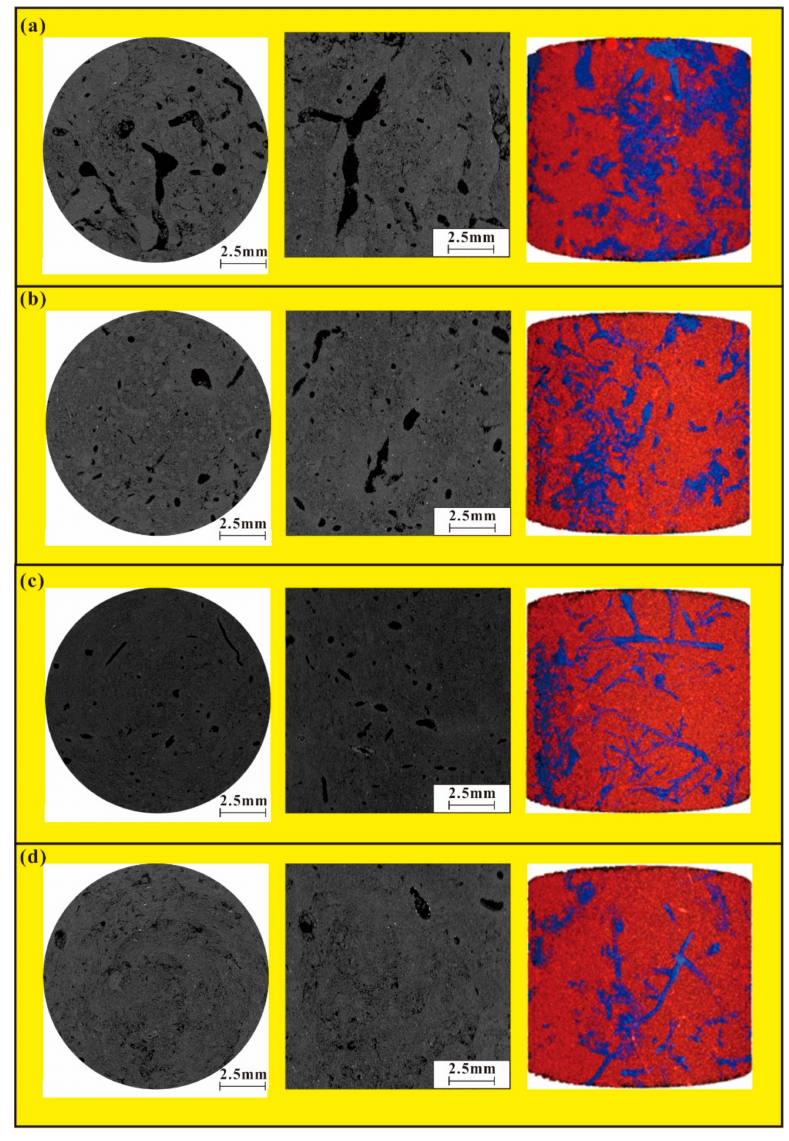
Figure 7. Reconstructed 3D models of the soil samples: ( a ) 1-1, ( b ) 6-1, ( c ) 6-2, and ( d ) 6-3.